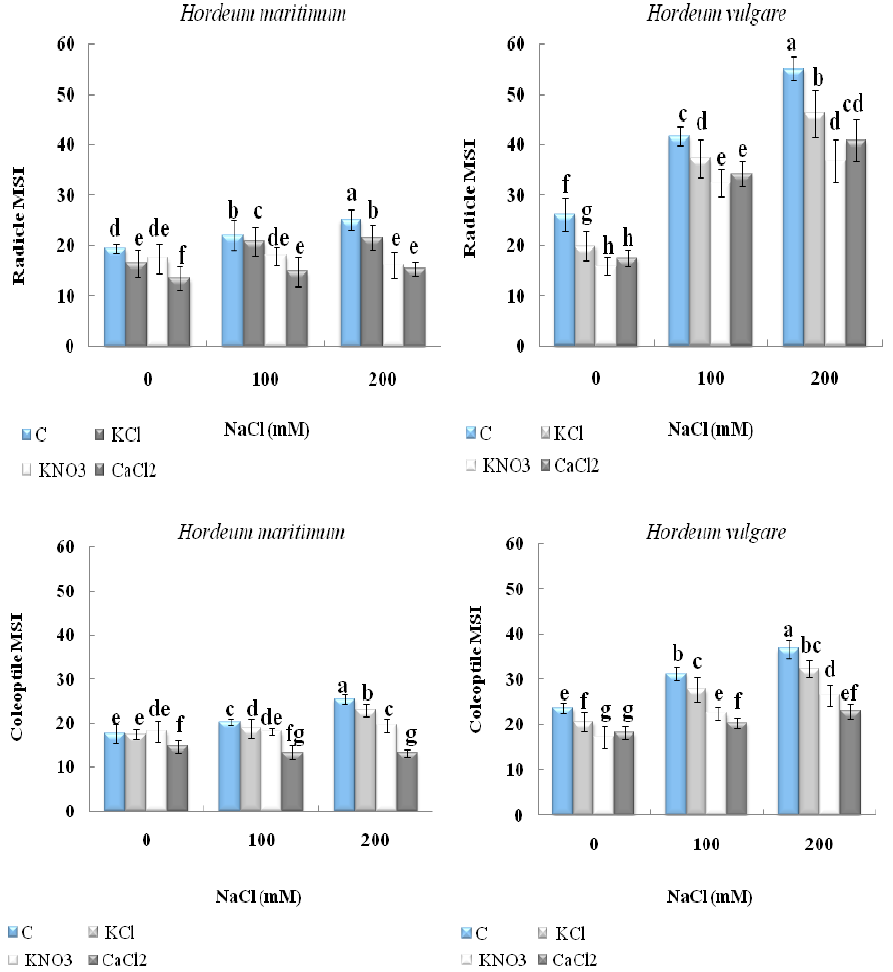
Figure 5. Effect of KCl, KNO 3 , and CaCl 2 seed priming on the membrane stability index (MSI) on the radicle and coleoptile of two barley species, Hordeum maritimum and Hordeum vulgare (L. Manel), subjected to various salt concentrations (0, 100, and 200 m MNaCl) for 7 days in the germination stage. Values are the means of 5 independent replicates ± standard error. Data with the same letter are not significantly different at p < 0.05 (Duncan’s test).